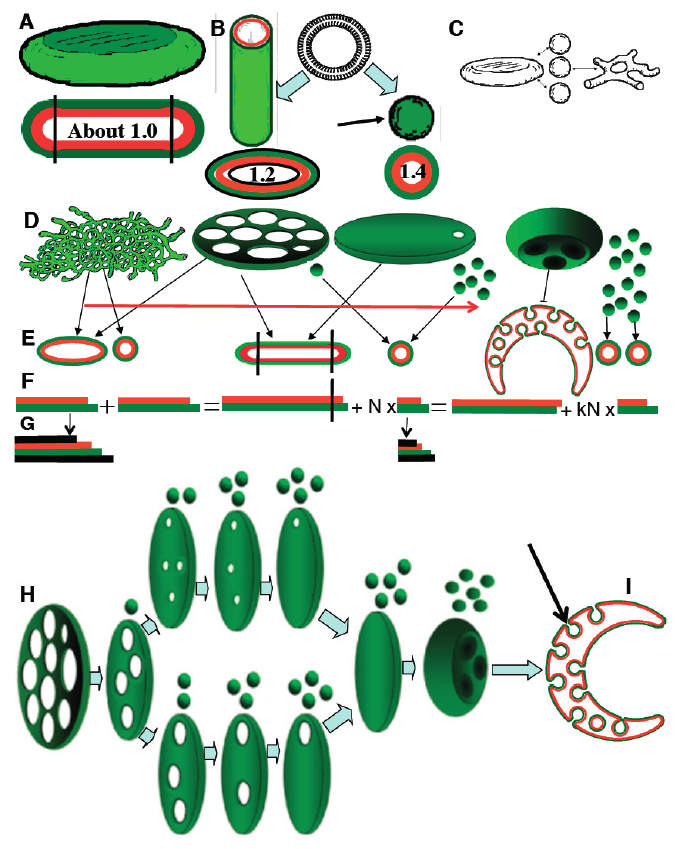
Figure 1. The model of the trans- membrane area asymmetry (TAA) redistribution. ( A ) Scheme of a lipid bilayer; ( B ) Planar lipid bilayer; ( C ) Closed, spherical lipid bilayer; ( A – C ) Different structural elements of the Golgi: disk ( A ), cylinder ( B ) and sphere ( B , arrow). Assuming the bilayer thickness of 4 nm, the diameter of the sphere and the cylinder of 52 nm, and the thickness of the disk of 30 nm, the TAA values for the membrane disk ( ≈ 1.01), the cylinder (1.2), and the sphere (1.4) are indicated inside schemes showing a section of the corresponding geometrical figures; ( D – F ) Schematic representation of a Golgi tubular network transforming (from left to right) into a perforated disk and a few vesicles, and subsequently into an invaginated disk with internal buds and many vesicles; ( E ) Cross-sectional view of the structural elements of the Golgi. N and kN indicate the number of 52 nm vesicles. Orange, luminal monolayer; green, cytosolic monolayer; ( F ) TAA and the average ratio between the surface area of cytosolic (green) and luminal (orange) membrane leaflets remain constant in spite of the dramatic changes in GA morphology; ( G ) Scheme of the situation with membrane images after fixing of cells with OsO 4 , when atoms of osmium are precipitated on the external and internal surfaces of the lipid bilayer; ( H ) Two ways of transformation of a highly perforated disk during vesicle budding into a smooth disk, and ultimately, into an invaginated disk with internal buds ( H , arrow); ( I ) The invaginated disk with internal buds has a TAA <